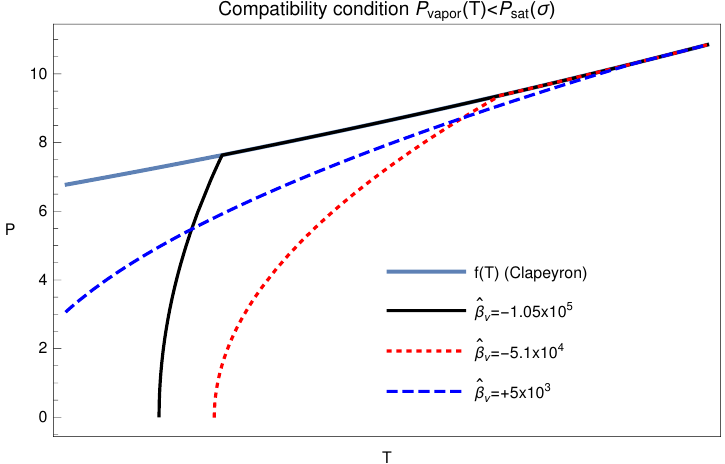
Figure 2. Check of the compatibility condition (18) for case